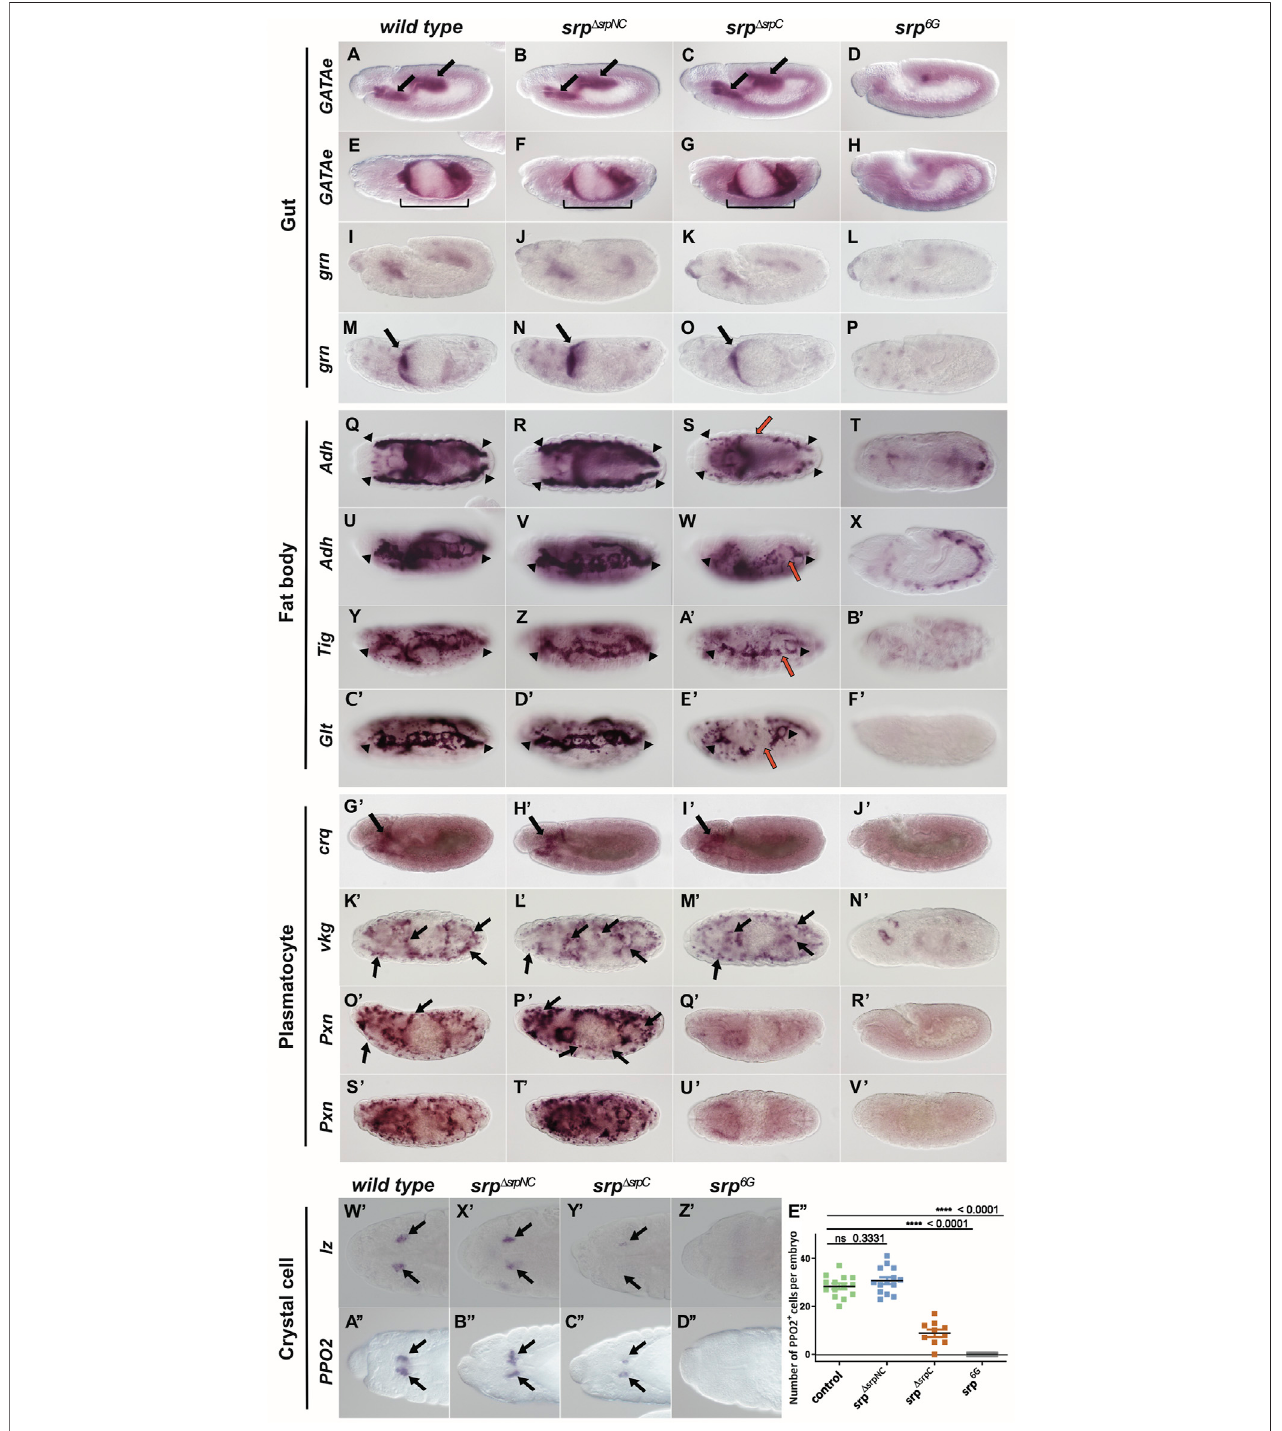
FIGURE4| SrpChasessentialfunctionsthatareonlypartiallycompensatedbySrpNCduringembryonicdevelopment.Wholemount insitu hybridizationofmRNAsexpressedin developinggut, GATAe (A – H) and grain ( grn , I – P ),maturefatbodycells, Alcoholdehydrogenase ( Adh , Q – X ), Tiggrin ( Tig , Y – B ’ )and Glutactin ( Glt , C ’– F ’ ),plasmatocytes, croquemort ( crq , G ’– J ’ ), viking ( vkg , K ’– N ’ )and Peroxidasin ( Pxn , O ’– V ’ ),crystalcells, lozenge ( lz , W ’– Z ’ )and Prophenoloxidase2 ( PPO2 , A ”– D ” )inwild-type, srp Δ srpNC , srp Δ srpC and srp 6G embryos (genotypesareshownontopofeachcolumn).Embryonicstagesare12 (A – D,I – L,G ’– J ’ ) ,13 (W ’– D ’’ ) ,15 (E – H,M – P,O ’– R ’ ) and16 (Q – F ’ ,K ’ ,N ’ ,S ’– V ’ ) .Althoughallaspects ofgutdevelopment( A – P ;blackarrowsandbrackets)andplasmatocytedevelopment( G ’– V ’ ;blackarrows)aresimilarinwild-type, srp Δ srpNC and srp Δ srpC conditions,fatbodyformation ( Q – F ’ ;delimitedbyblackarrowheads;redarrowspointtofatbodydefects),plasmatocytespeci fi c Pxn expression (O ’– V ’ ) andcrystalcelldevelopment( W ’– D ” ;blackarrows)arealtered in srp Δ srpC comparedtowild-typeand srp Δ srpNC ,butnotasmuch asin srp 6G , whereboth srp isoformsaredepleted. (E ’’ ) Quanti fi cationof PPO2 expressingcrystalcellsinwild-type, srp Δ srpNC , srp Δ srpC and srp 6G embryos. p -values represent results of a Mann-Whitney test comparing the wild-type with the indicated genotype.